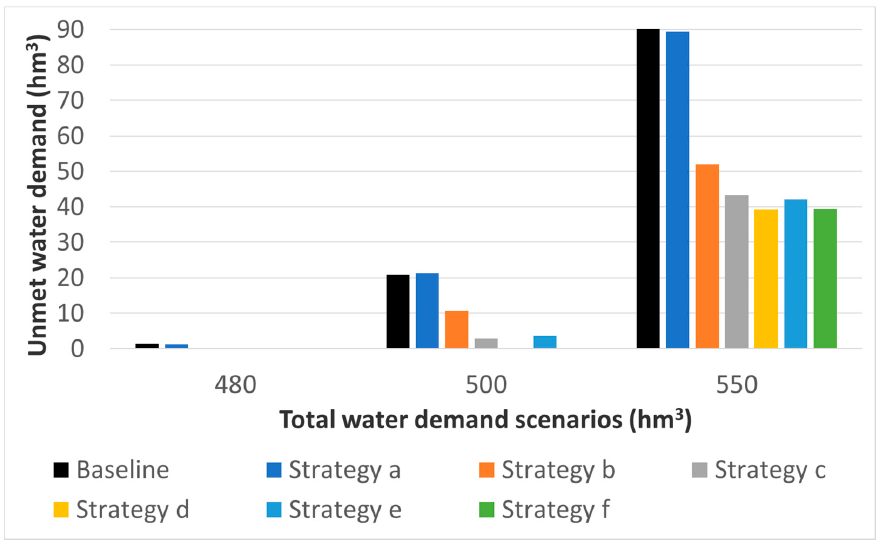
Figure 5. Unmet water demand in hm 3 for water supply timeseries 4, water demand scenarios 3, 4, and 5 and all the water demand management strategies.